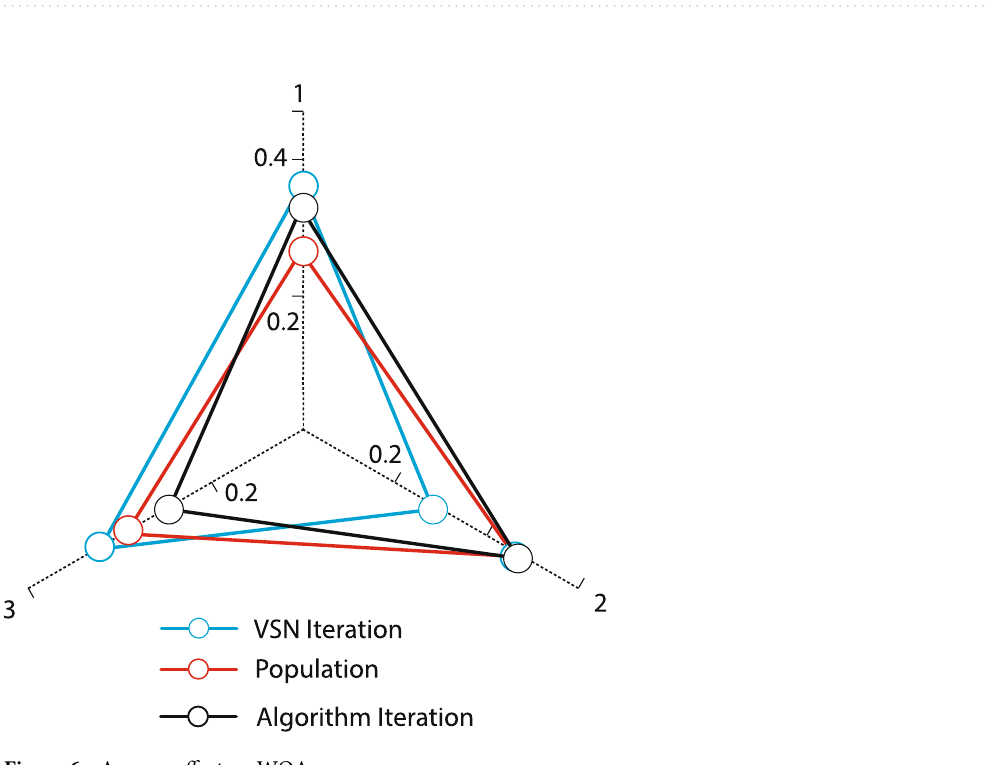
Table 3. Orthogonal table for adjusting WOA’s parameters.